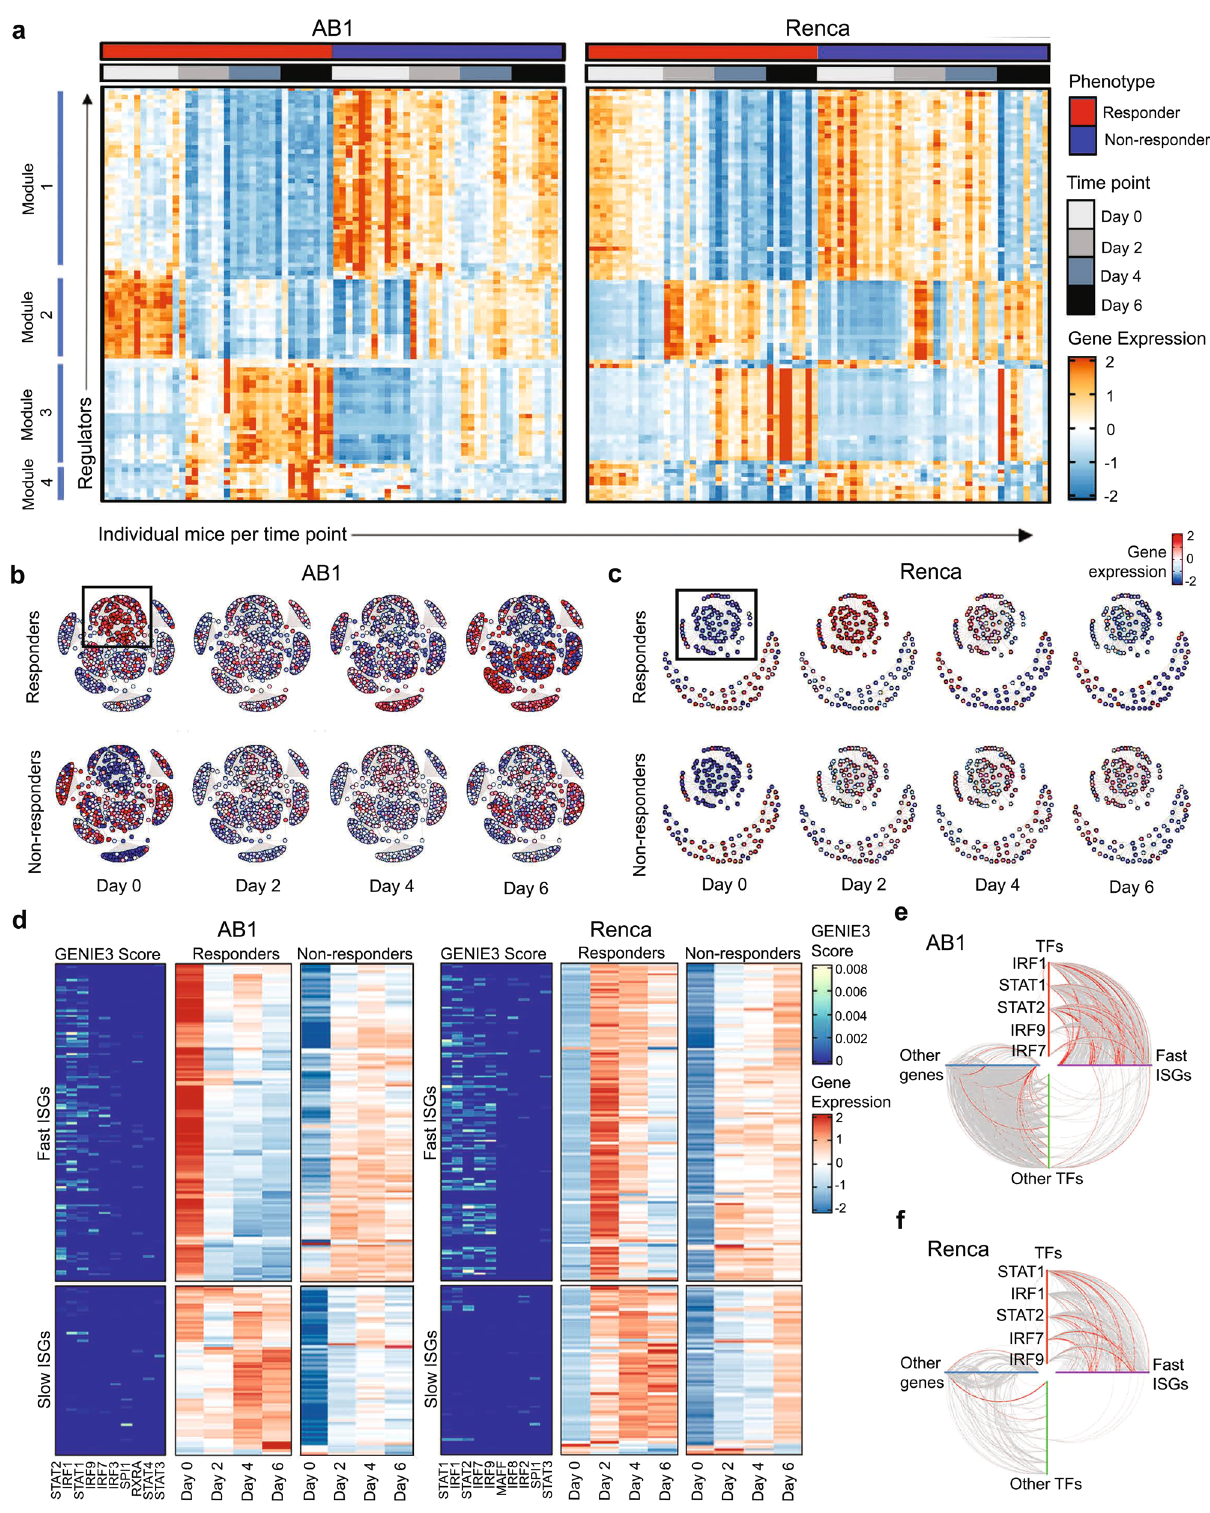
Fig. 3 | Time-dependent changes in expression of a common subset of IFN regulatorsdisplayingon/fast-offkineticsdistinguishICBrespondersfromnon- responders. a Expression of the top 100 regulators ranked by GENIE3 importance scoreplottedpermouseintimebytheresponse,genesweregroupedbyhierarchal clustering. b GENIE3subnetworkofdirectinteractionsbetweenTFsandtheirtarget genes in AB1 and ( c ) in Renca, separated into responders and non-responders, depicting gene expression over time, with on/fast-off IFN genes highlightedwithin